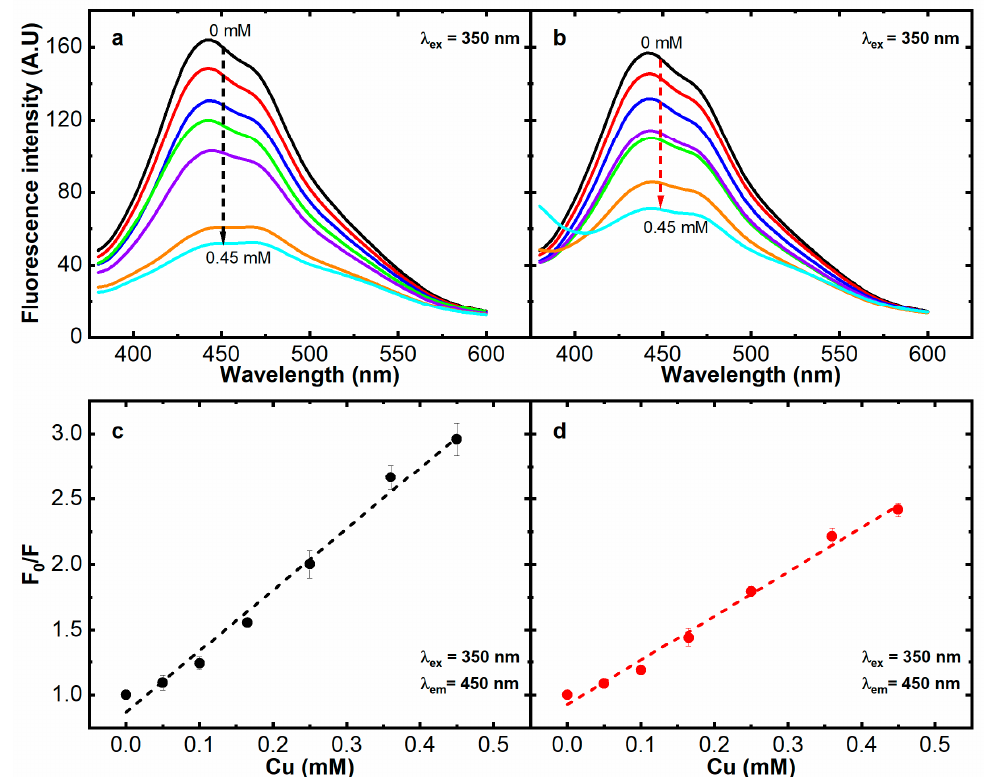
Figure 6. Fluorescence spectra and the relative calibration plots of the SEDF after copper ion addi- tion in buffer ( a , c ) and in artificial urine samples ( b , d ). The fluorescence was recorded at 450 nm ( λ ex = 350 nm) and reported as a F 0 /F versus Cu 2+ concentration (0, 0.010, 0.050, 0.100, 0.165, 0.250, 0.350, and 0.450 mM), where F 0 and F represent the fluorescence intensity of the SEDF before and after the copper addition, respectively. The error bars represent the standard deviation (n = 4). The analytical parameters are reported in Table S1.